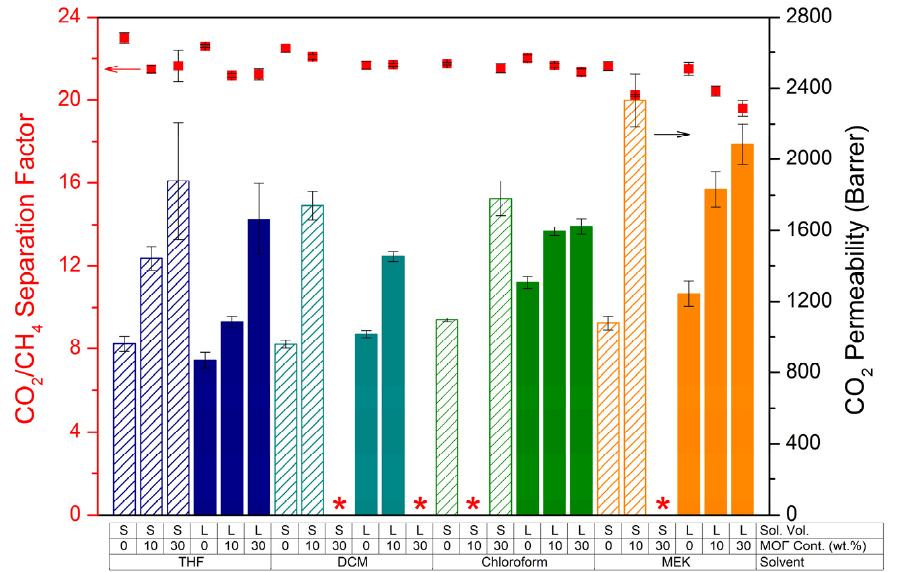
Figure 3. CO 2 /CH 4 separation factors ( dots ) and CO 2 permeabilities ( bars ) of 6FDD and MMMs cast from 5 wt.% polymer solutions prepared with different solvents. “S” and “L” indicate the small and large solution volume, respectively. Red stars correspond to the membranes with no valid results due to the brittleness or defects.